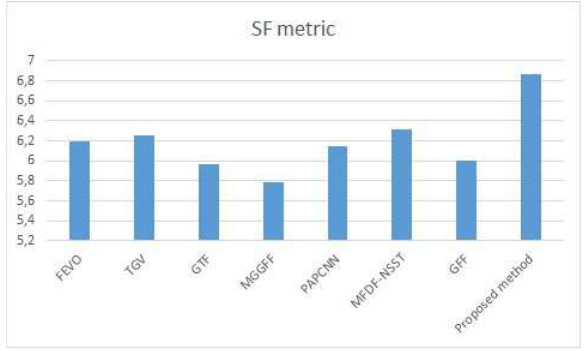
Figure 8. Diagram of the quality assessment by SF metric